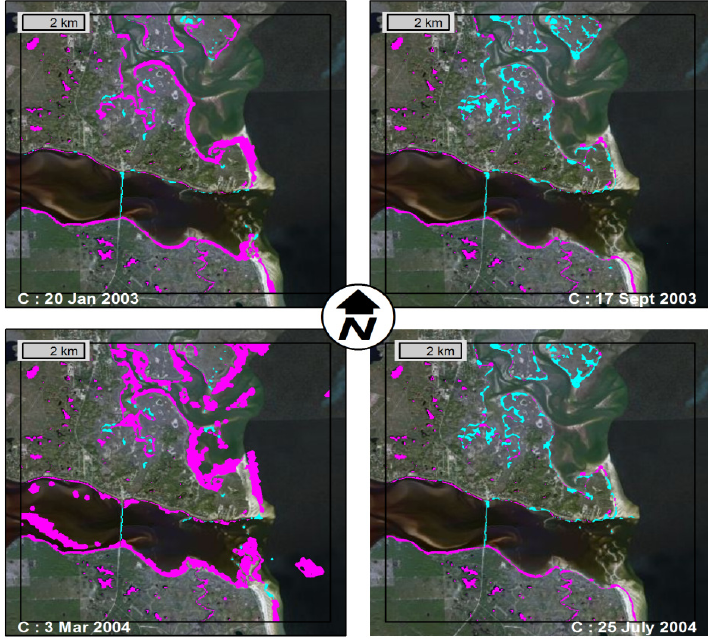
Figure 9. Synoptic inundation results for Assessment Area C (Ochlockonee Bay). Pixels incorrectly predicted as DRY are shown in magenta; pixels incorrectly predicted as WET are shown in cyan. Other areas within the square boundary were